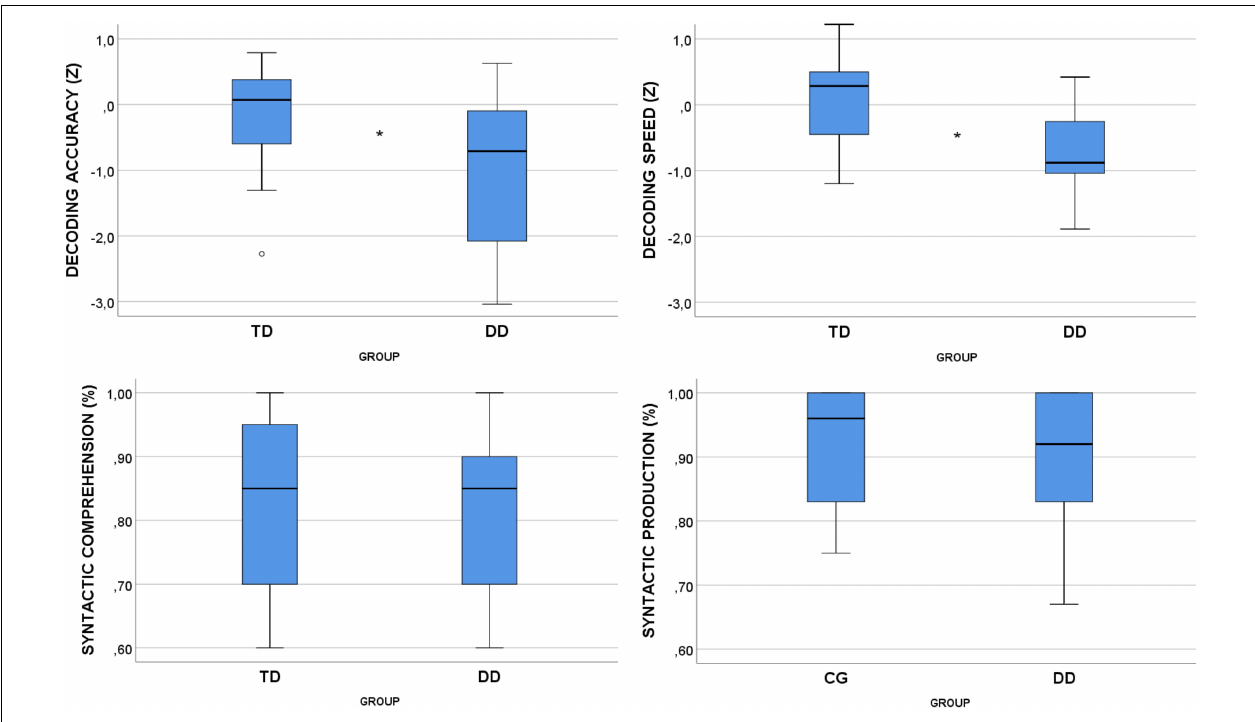
FIGURE 2 | Distribution of decoding standard scores and syntactic percent scores (* p < 0.05).